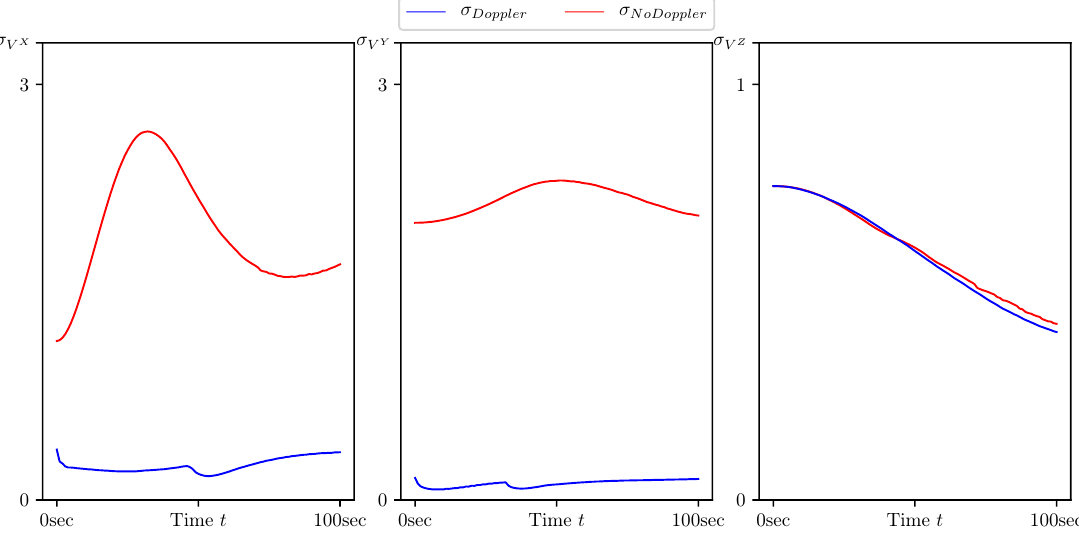
) calculated , V Y , V Z t t t